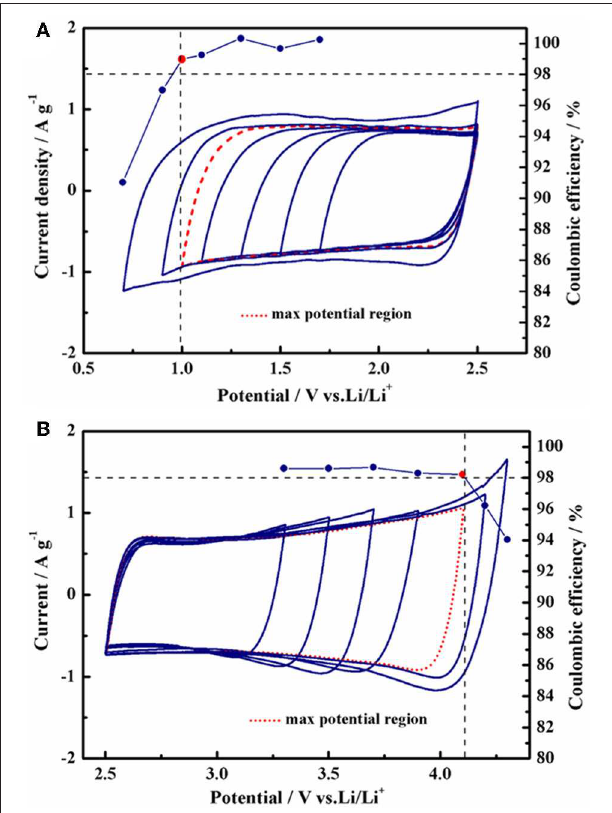
FIGURE 4 | Operating potential determination using cyclic voltammetry. Coulombic efficiency (right axis) of cells used in the determination of anodic/cathodic limits. (A) Negative, (B) positive scans in different windows of the half-cell using 1mol L − 1 Py 13